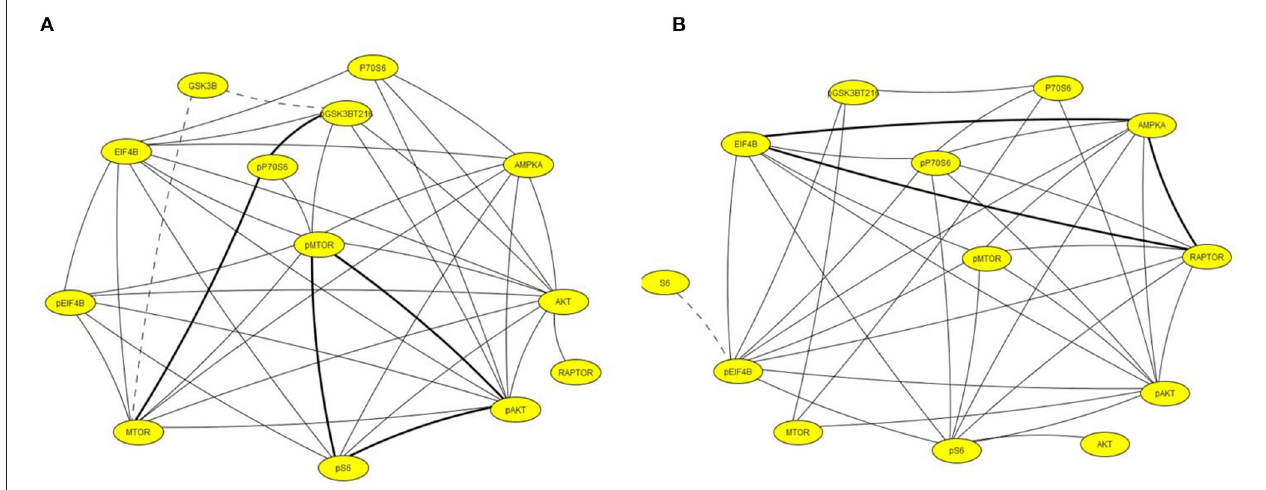
FIGURE 5 | Correlation networks including components of the MTOR pathway in (A) hippocampus and (B) cortex. Correlations between protein levels were determined by Spearman Correlation analysis; only correlations with r > 0.8, with linear scatter plots and p < 0.05 were considered significant and are included. Heavy solid lines, correlations seen in pilocarpine and saline treated mice; thin solid lines, correlations seen only in pilocarpine treated mice; dashed lines, correlations seen only in saline treated